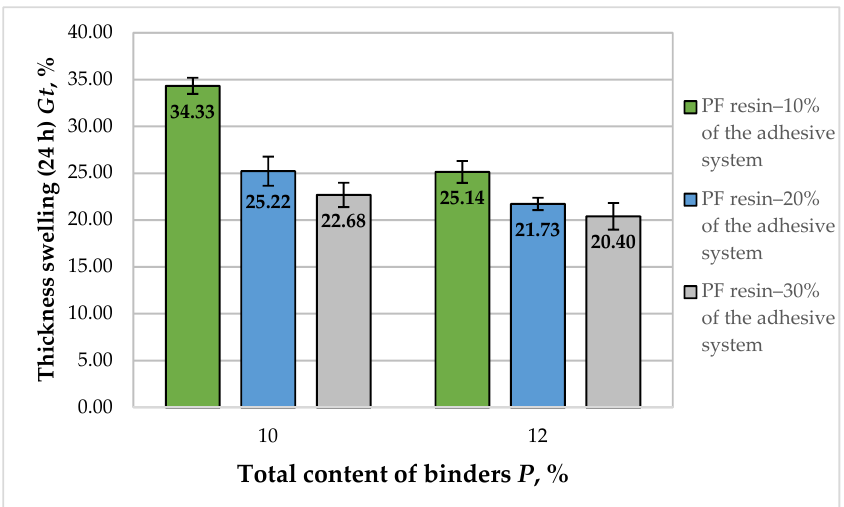
Figure 9. Thickness swelling (24 h) of fiberboard panels bonded with HL and PF resin.